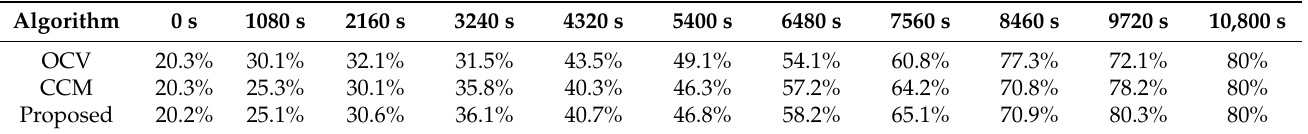
Figure 12. SoC comparison profile graph. Table 2. SoC profile of the batteries according to the